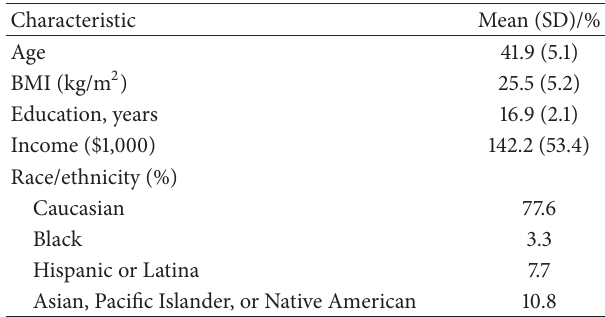
Table 1: Participant demographics from the current study ∗